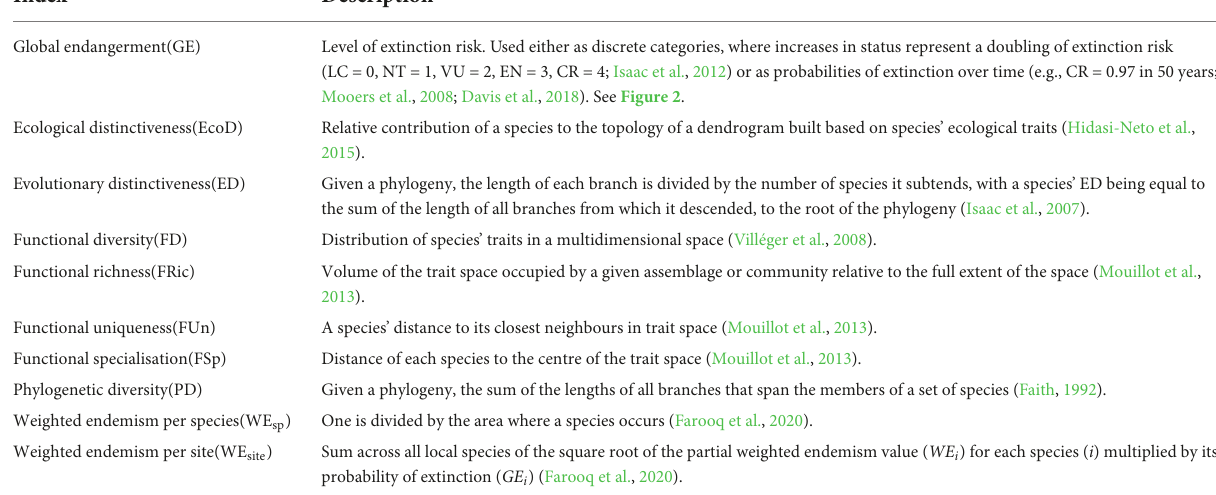
TABLE 1 Glossary of indices and abbreviations used in International Union for Conservation of Nature (IUCN)-based prioritisation metrics.